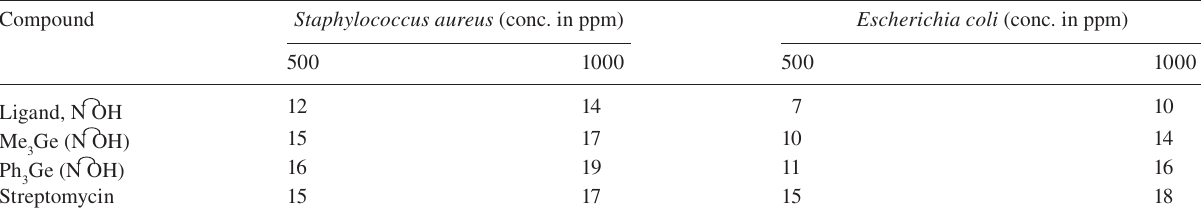
Table 3 Antibacterial screening data of the ligand and its organogermanium complexes. Compound